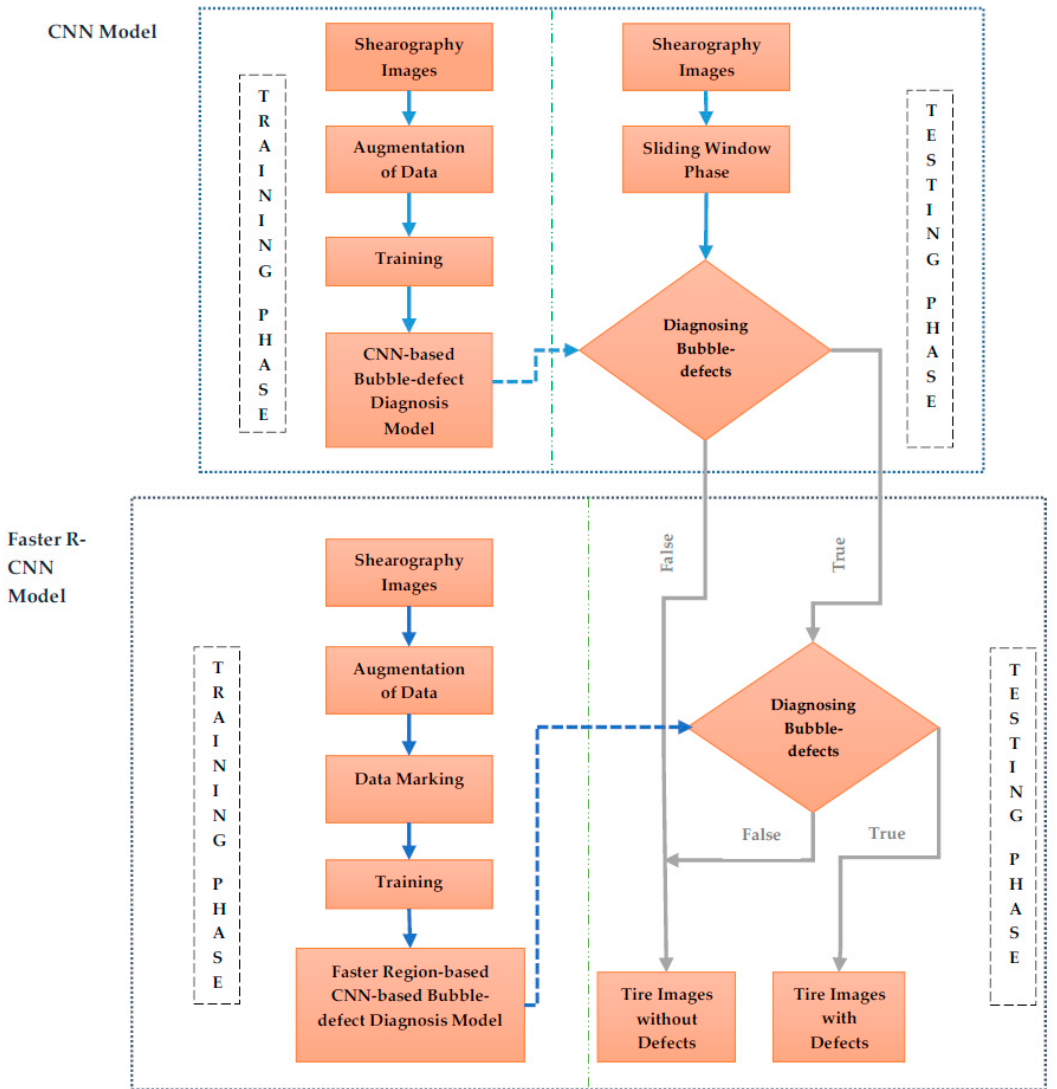
Figure 3. Flow diagram of the proposed two-stage ensemble hybrid model.